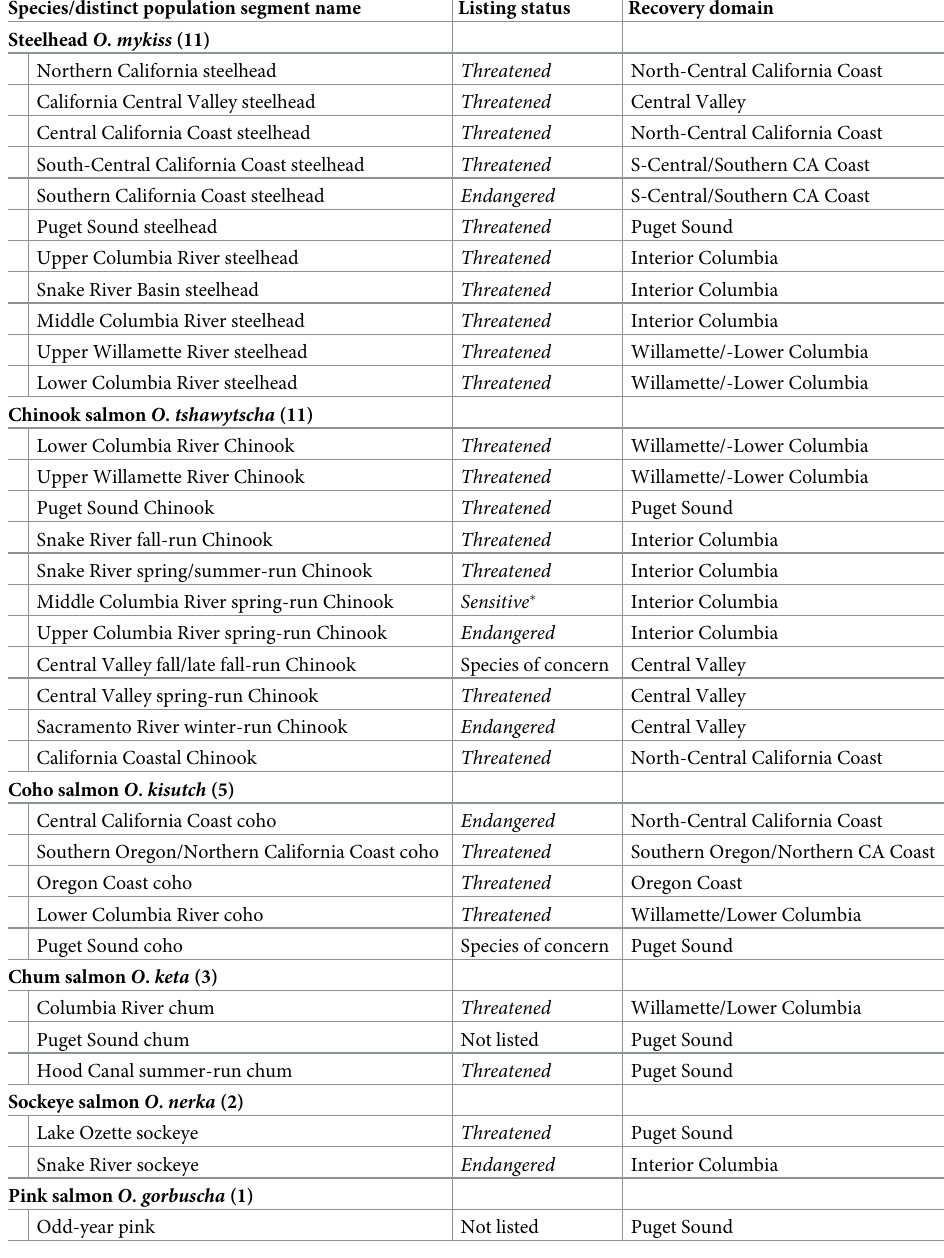
Table 1. Salmon and steelhead distinct population segments (DPSs) included in the assessment. Species names are shown with number of DPSs in parenthesis. Name, listing status, and recovery domain is also shown for each